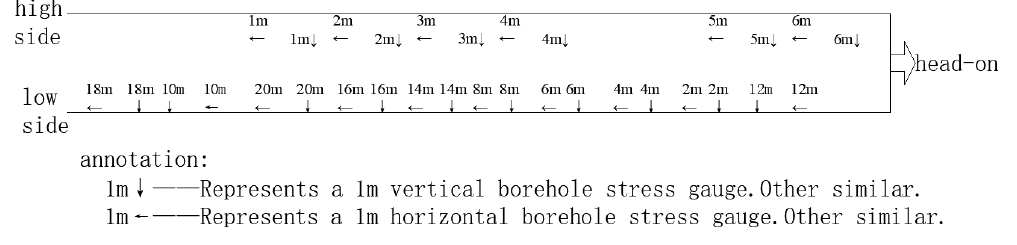
Figure 6. 12521 Graphic layout of measuring station.